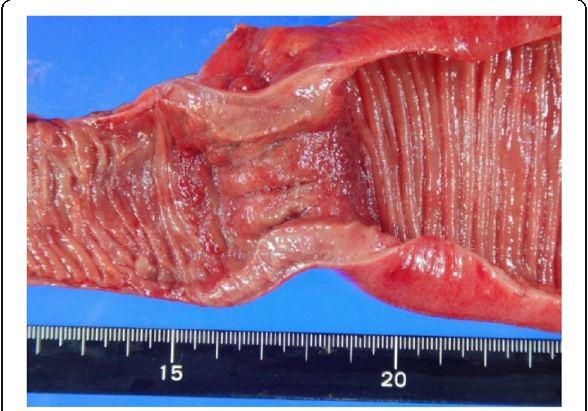
Fig. 3 Resected mass measured approximately 60 × 50 mm. The mass, which was elastic and hard, blocked the entire circumference of the elevated cut